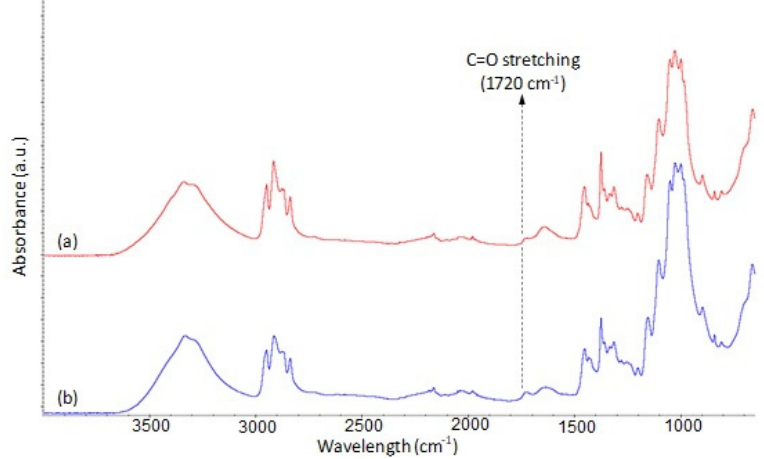
Figure 5. IR spectra of ( a ) Flax/PP and ( b ) Pm-Flax/PP (150 W) fabrics.